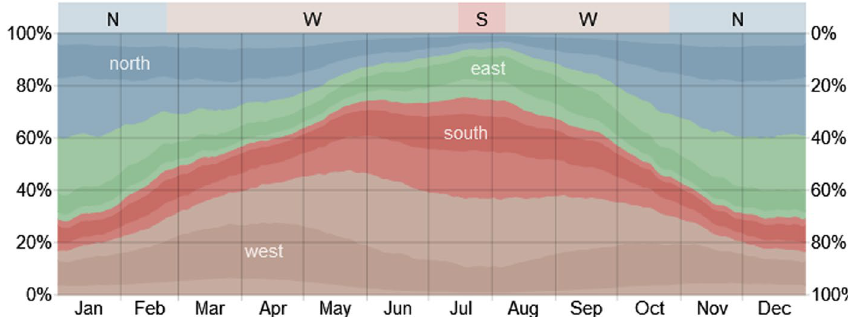
Fig. 18 Annual wind direction in the vicinity of the ports LA&LB. Source: Weather Spark